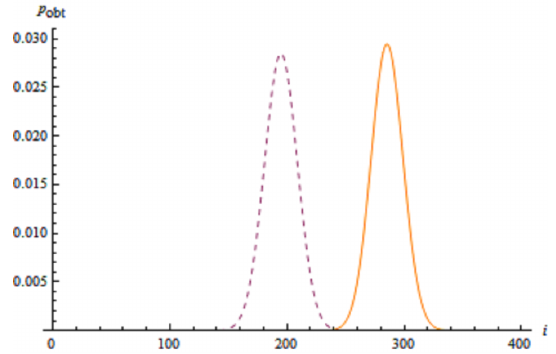
Figure 5. The solid line denotes the probability of an honest Bob obtains i conclusive bits when N = 800, µ = 5. It can be seen that an honest Bob can obtain more than 259 conclusive bits with a great probability. The dashed line denotes the probability of a malicious Bob obtains i + 259 conclusive